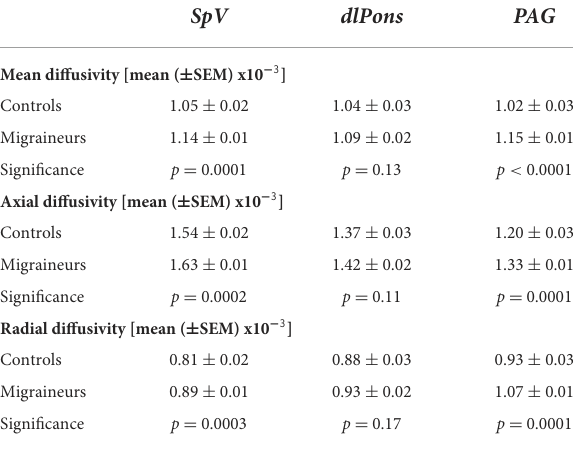
TABLE 2 Diffusion and p- values for significant brainstem clusters in migraineurs and